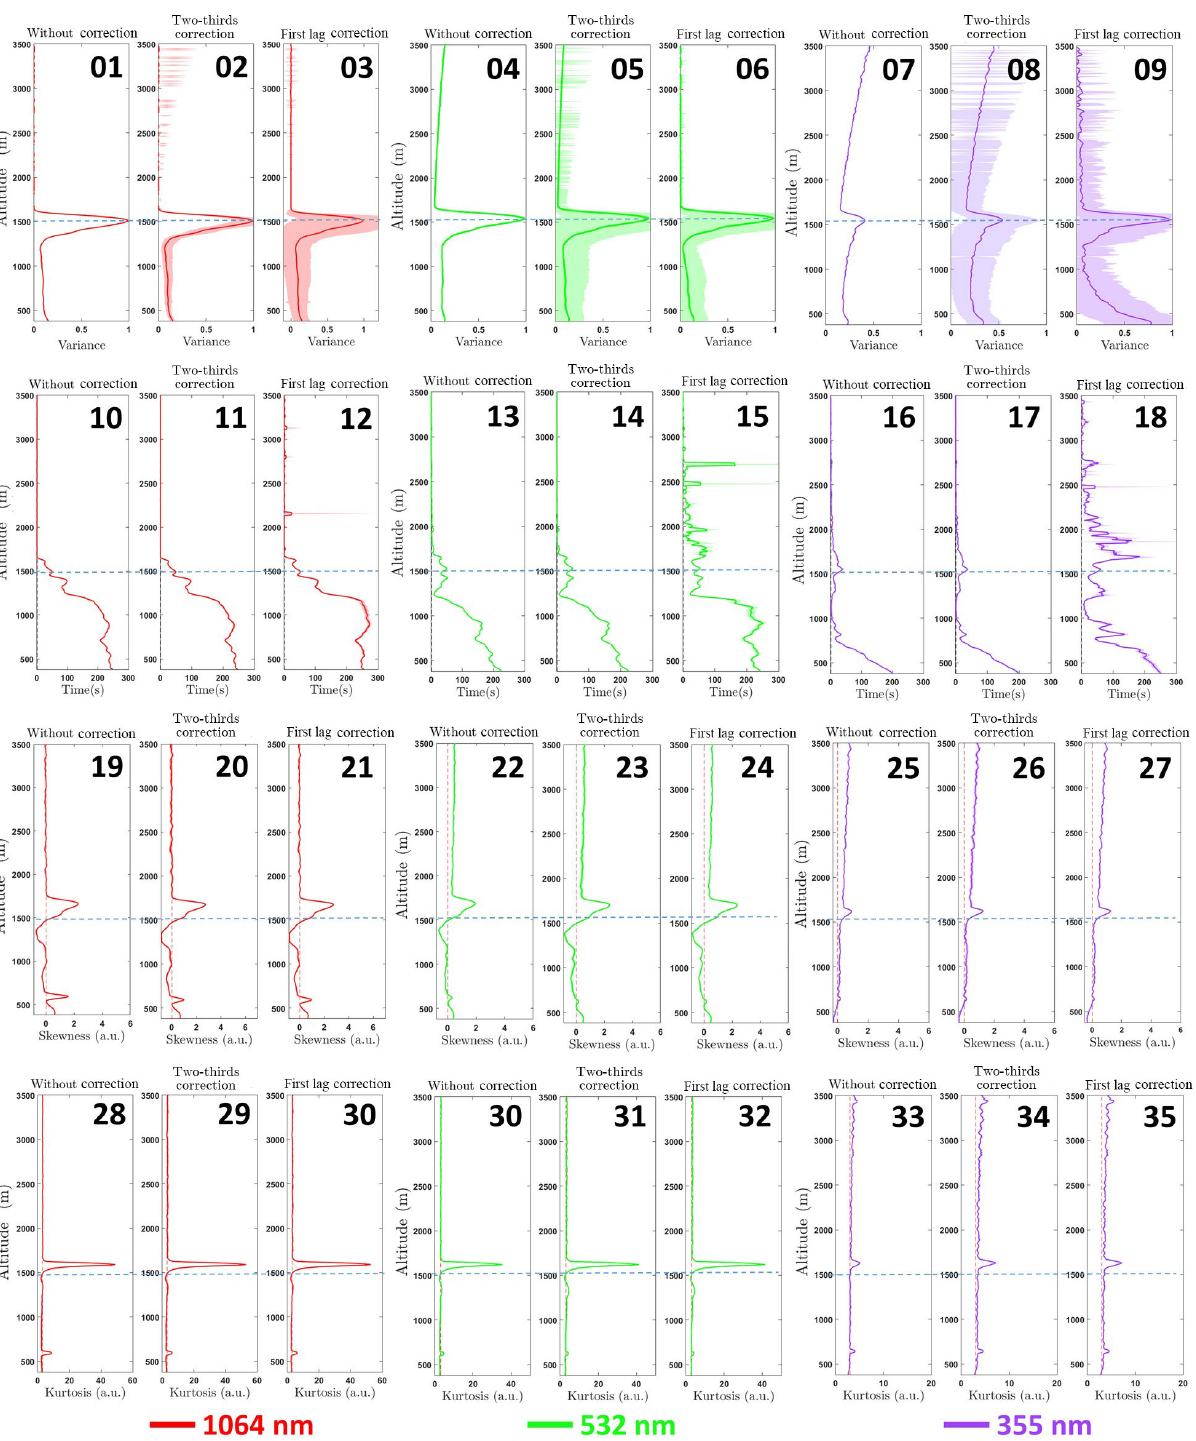
Figure 6. High-order moments and τ without correction and corrected by the two-thirds law and first lag correction at 1064 (red line), 532 (green line) and 355nm (violet line) on 26 July 2017 from 17:00 to 18:00UTC. The horizontal dotted blue line represents the ABLH elastic